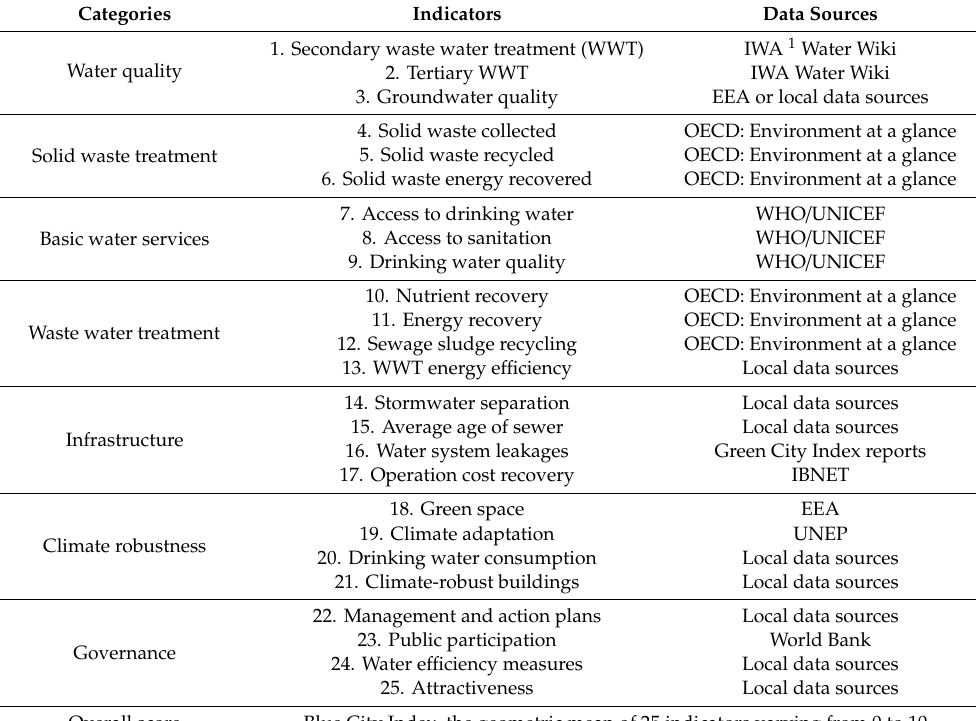
Table 2. Indicators of the City Blueprint Framework and data sources